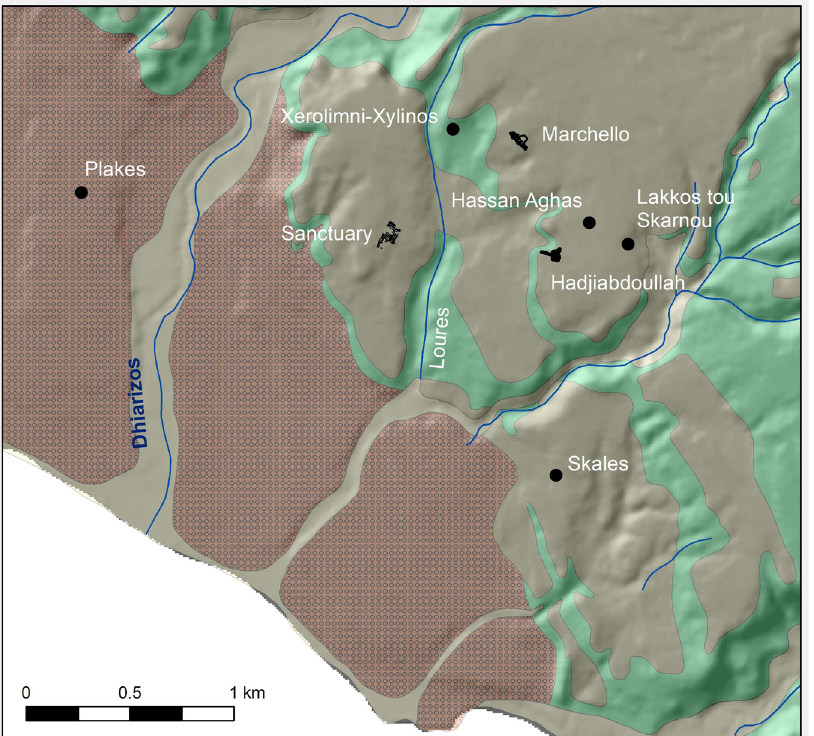
Figure 24. Geological map of the wider Palepaphos area with location of Iron Age burial sites. Drafted by A. Agapiou